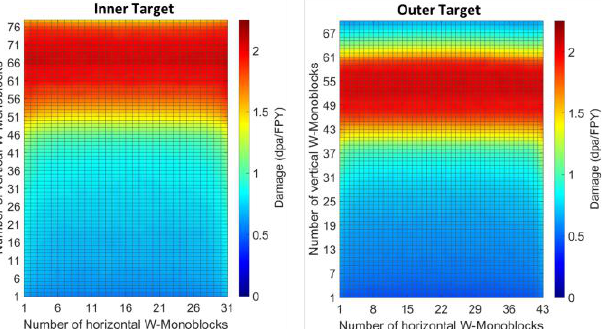
Figure 17. Nuclear damage (dpa/FPY) distribution on W-monoblocks of the inner ( left ) and outer ( right ) target, with WCLL blanket.